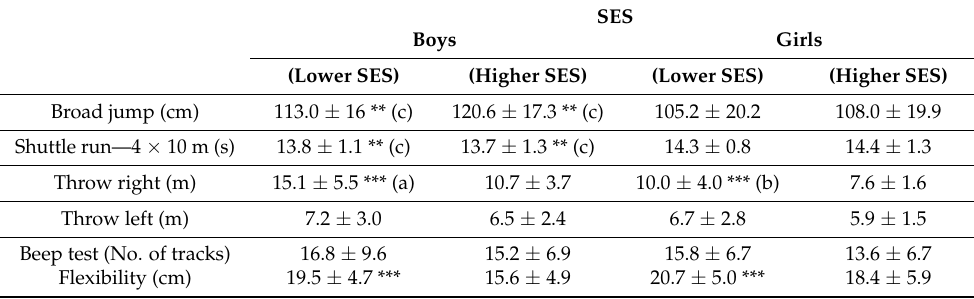
Table 6. Physical fitness performance considering SES and sex of